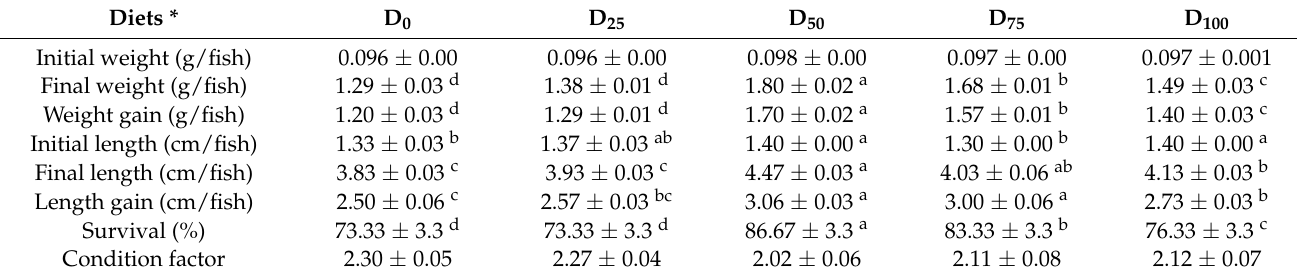
Table 4. Effect of partial or total replacement of fishmeal by amphipod meal, Gammarus pulex , on growth performance of Mugil cephalus